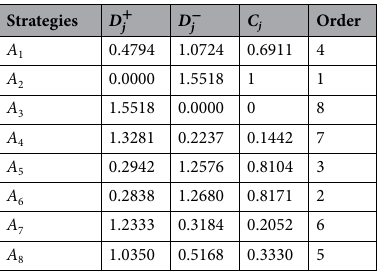
Table 12. Results of fuzzy TOPSIS method and the ranked order of the strategies.